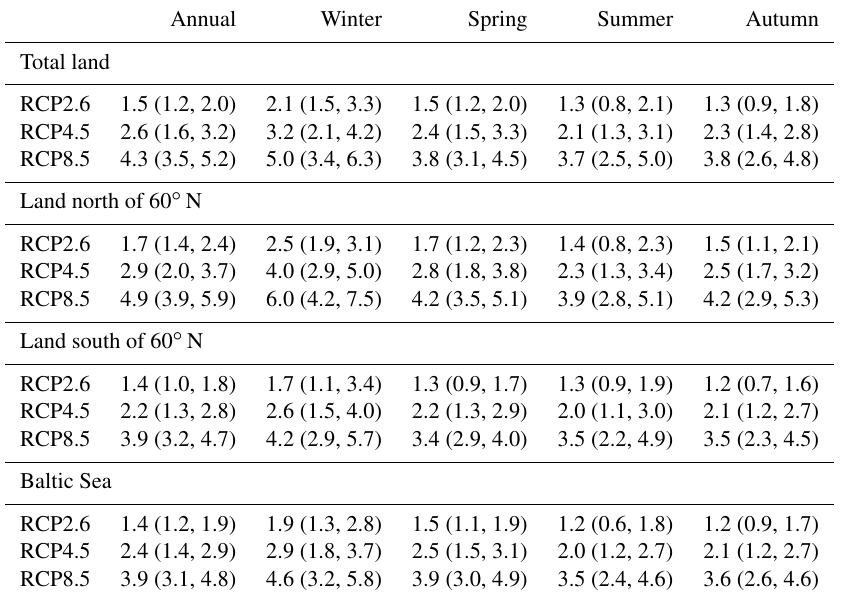
Table 12. Air temperature ( T 2m ) changes (degrees Celsius) between 1976–2005 and 2069–2098, averaged over each season, and the annual mean over the Baltic Sea catchment area and over the Baltic Sea calculated from nine dynamically downscaled ESM simulations. In addition to the ensemble mean change, the 5th and 95th percentiles indicating the ensemble spread are listed (in parentheses). Data source: Gröger et al.,